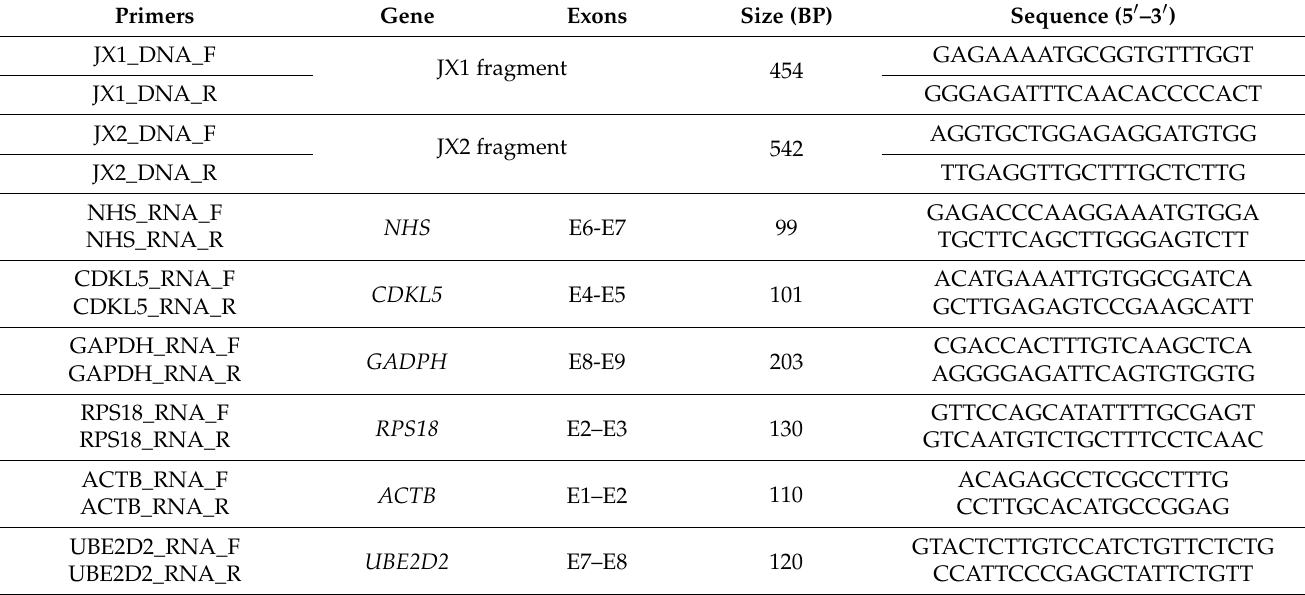
Table A2. PCR and RT-PCR